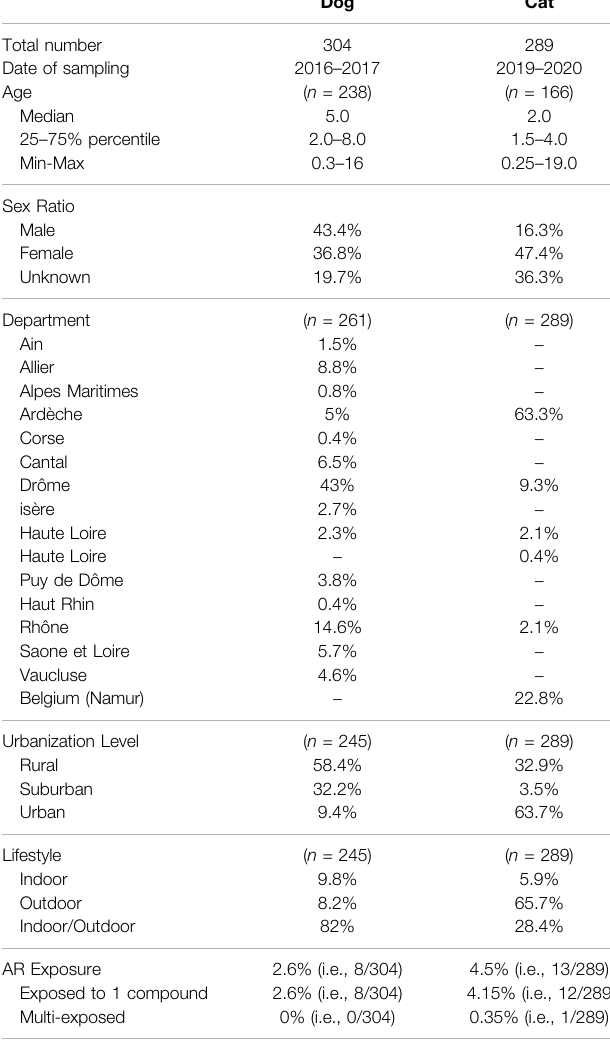
TABLE 1 | Description of the dog and cat